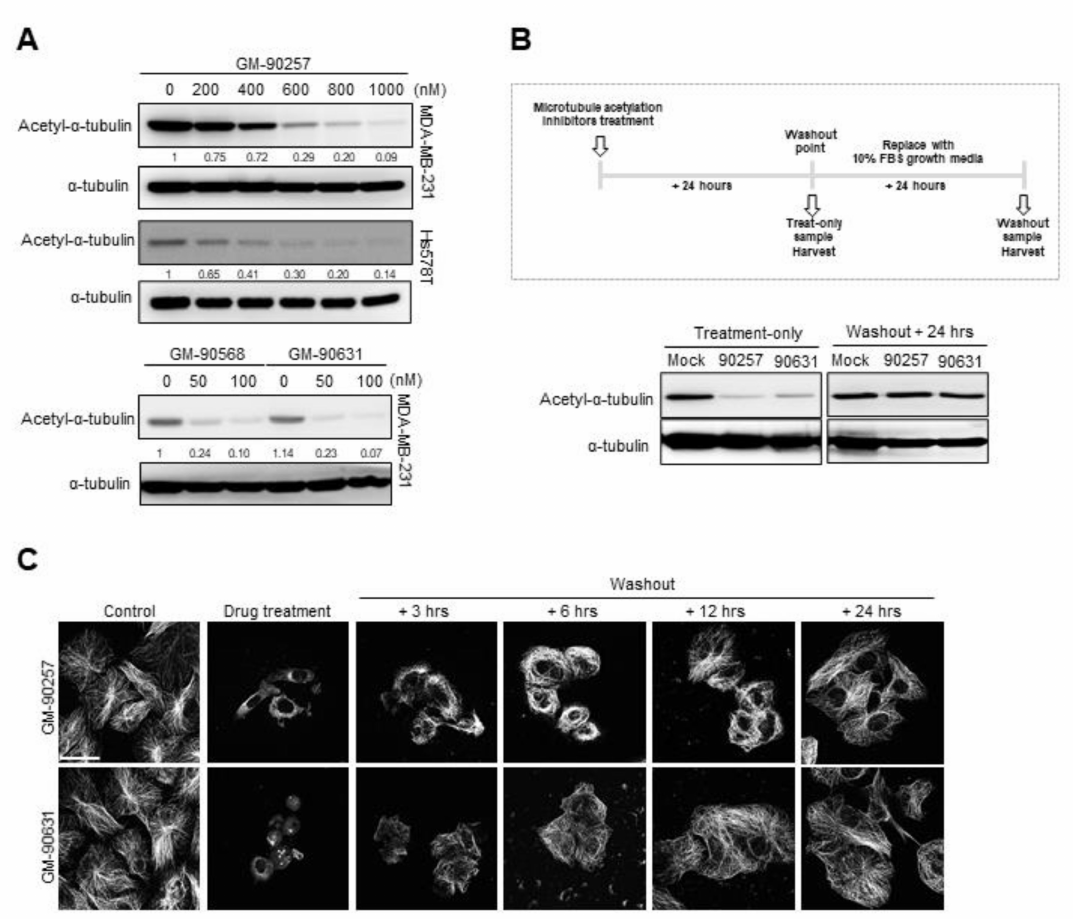
Figure 2. Reduction of microtubule acetylation in TNBC cell lines by selected microtubule acetylation inhibitors. ( A ) The expression of acetyl- α -tubulin in MDA-MB-231 and Hs578T cells treated with microtubule acetylation inhibitors was examined by western blotting. ( B ) GM-90257 (500 nM)